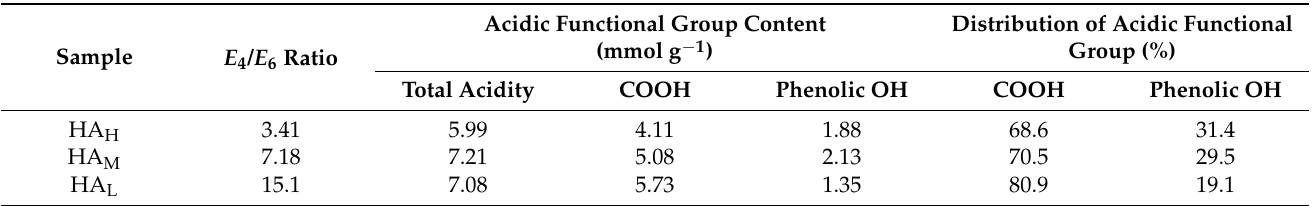
Table 2. The E 4 / E 6 ratio, acidic functional group contents and distribution of HA fractions derived from weathered coal.